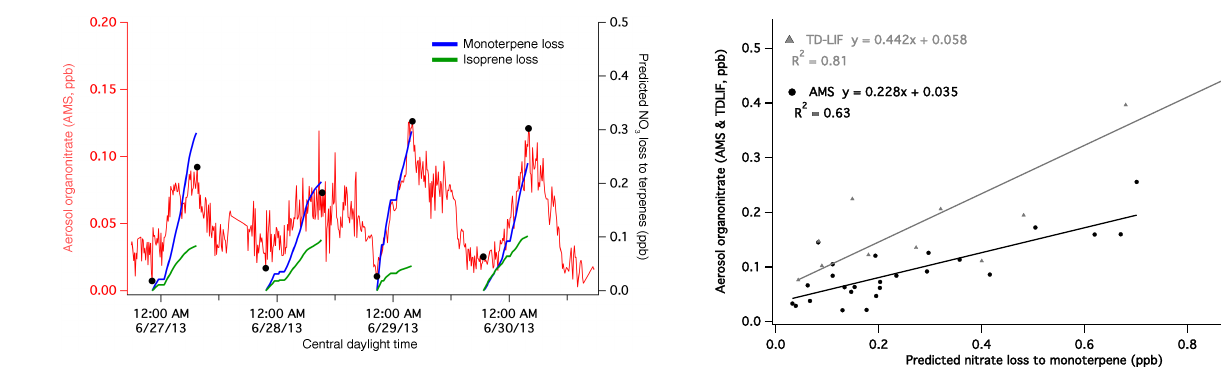
Figure 6. Scatter plots of aerosol RONO 2 (AMS and TD-LIF) com- pared to ( NO 3 , loss ) cum . The magnitudes of the two particle phase organic nitrate measurements differ by a factor of ≈ 2–4 for un- known reasons; however, the slope can be used as a relative molar yield of NO 3 loss to monoterpenes. Time period for AMS